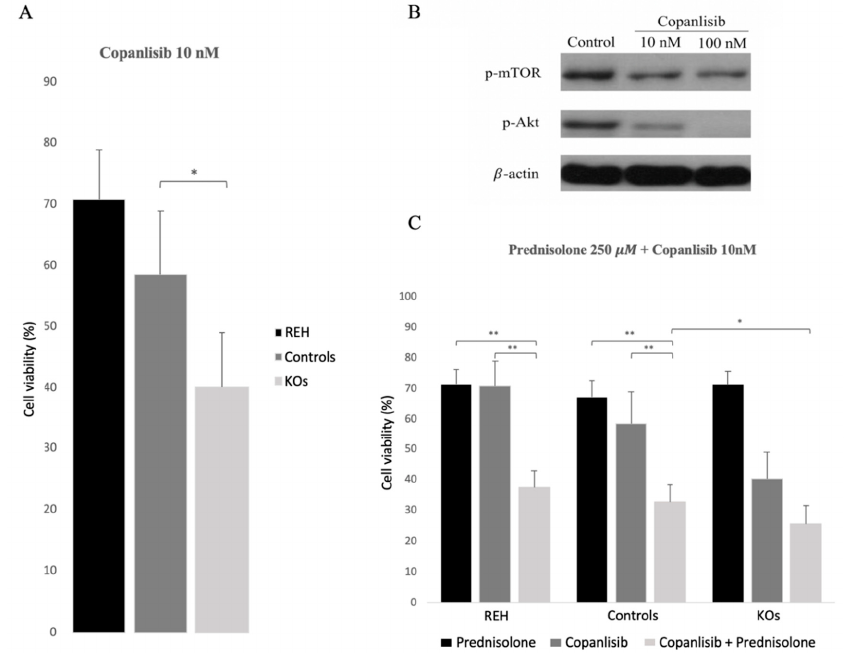
Figure 5. Cell viability and protein expression measured after Copanlisib / Prednisolone treatment. ( A ) Cell viability was measured by the 3-(4,5-Dimethyl-2-thiazolyl)-2,5-diphenyl-2H-tetrazolium bromide also named as Methylthiazolyldiphenyl-tetrazolium bromide (MTT) proliferation assay after treatment (192 h) with Copanlisib (10 nM). E/R KO clones (light grey square line) showed a higher sensitivity to Copanlisib than REH cells (black square line) and control clones (grey square line). This graph represents the average of three independent experiments and in turn the average of the 2 control clones and the 3 KO clones. ( B ) p-Akt (60 kDa) and p-mTOR (289 kDa) expression levels decreased after treatment with Copanlisib. ( C ) Prednisolone (black square line), Copanlisib (dark grey square line) and Copanlisib plus Prednisolone combination (grey square line) were tested in the different clones. The relative cell viability was calculated as the percentage of untreated cells. This experiment had three replicates. * p ≤ 0.05; ** p ≤ 0.005 (unpaired t -test).